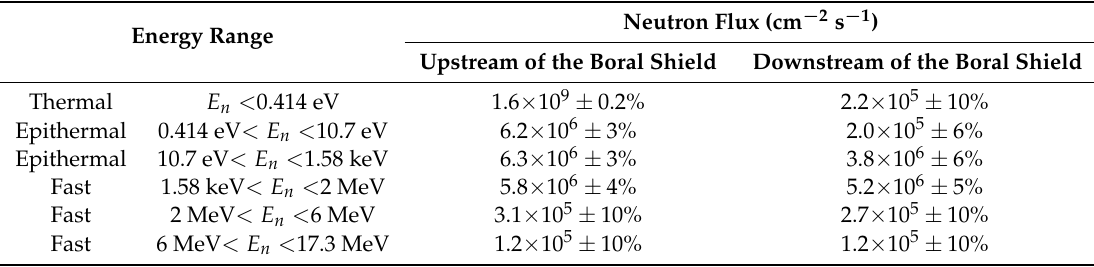
Table 2. Neutron flux components at the end of the channel inside the thermal column of the TRIGA Mark II reactor upstream and downstream of the Boral